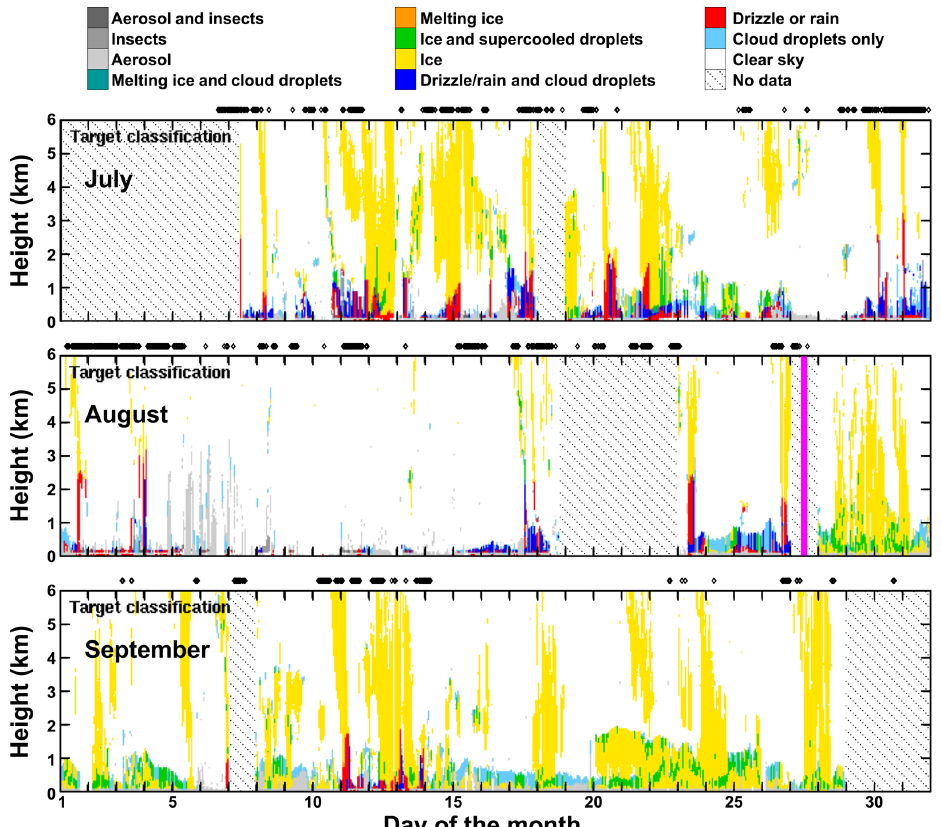
Figure 4. Cloudnet target classification for the 3-month ACSE cruise. Black diamonds above the monthly displays mark 10min periods of visibility below 1km. Hatched areas separate periods of no data from the white background of clear sky. The pink vertical line on 27 August 2014 marks the transition from summer to autumn as defined by Sotiropoulou et al.